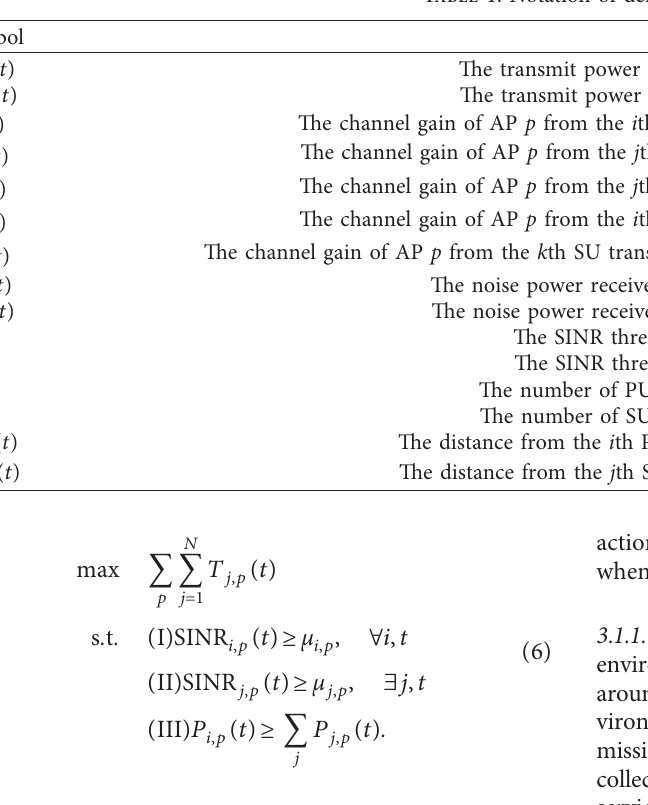
Table 1: Notation of